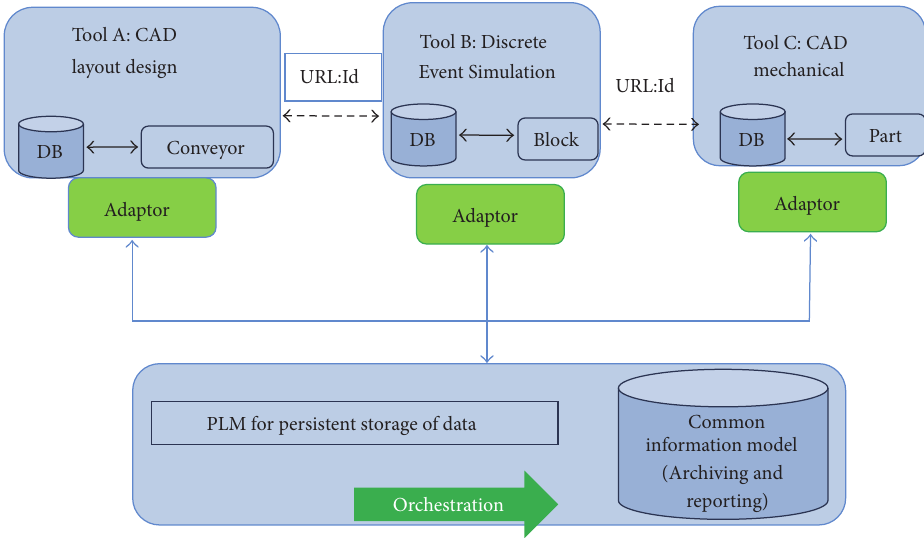
Figure 7: Integration based on OSLC and STEP in a complementary